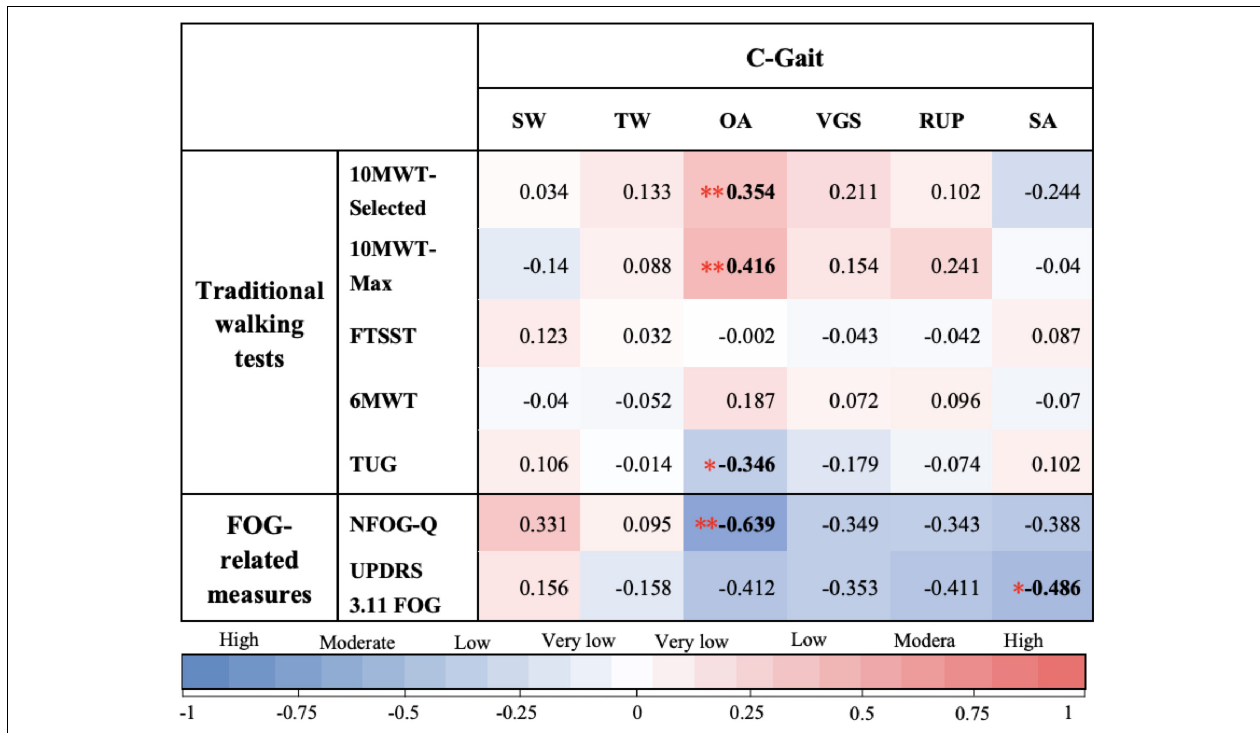
FIGURE 1 | Spearman’s correlation coefficients between C-Gait assessment scores. In this study, correlation coefficients of 0–0.25, 0.25–0.50, 0.50–0.75, and 0.75–1.00 were considered to indicate very low, low, moderate, and high correlations, respectively. Slalom walking (SW), tandem walking (TW), obstacle avoidance (OA), visually guided stepping (VGS), reaction to unexpected perturbation (RUP), and speed of adaptation (SA) were on the x -axis, while traditional walking test measures were on the y -axis, i.e., The New Freezing of Gait Questionnaire (NFOG-Q), Unified Parkinson’s Disease Rating Scale Part III, item 11, and Freezing of Gait (UPDRS 3.11 FOG). Color types and shades provide a visualization of the direction and strength of the correlations, respectively. The numbers shown in each square correspond to different colors, indicating the Spearman’s correlation coefficient (r s ) from Spearman’s rank correlation analysis of each pair. * Correlation is statistically significant at the P < 0.05 level; ** Correlation is statistically significant at the P < 0.01